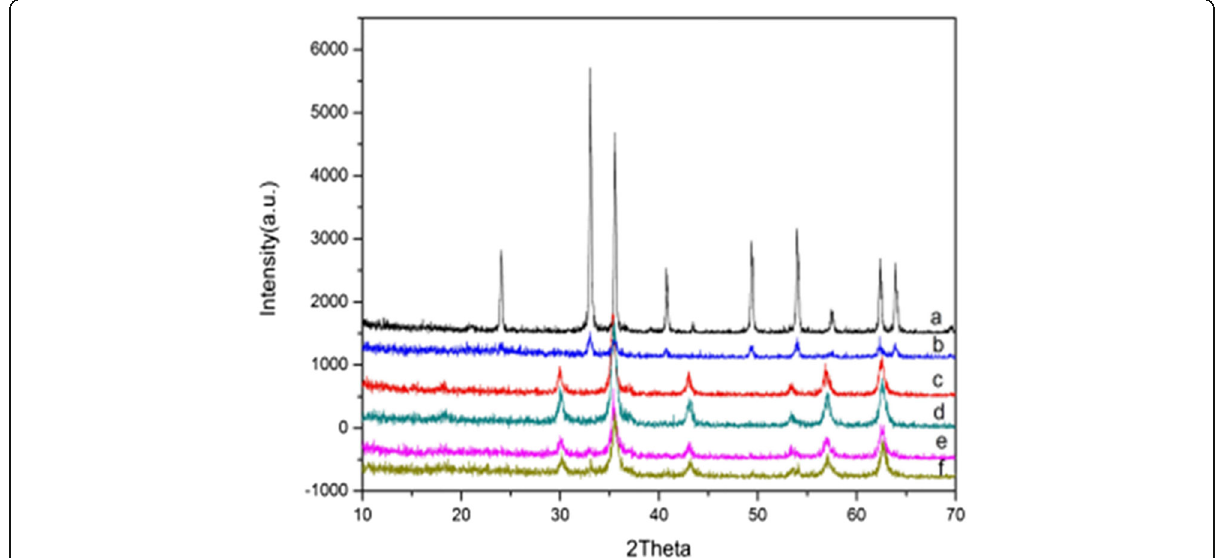
Fig. 3 XRD pattern of different amount of trisodium citrate synthesized sample. a 0 mmol. b 2 mmol. c 3 mmol. d 4 mmol. e 6 mmol. f 8